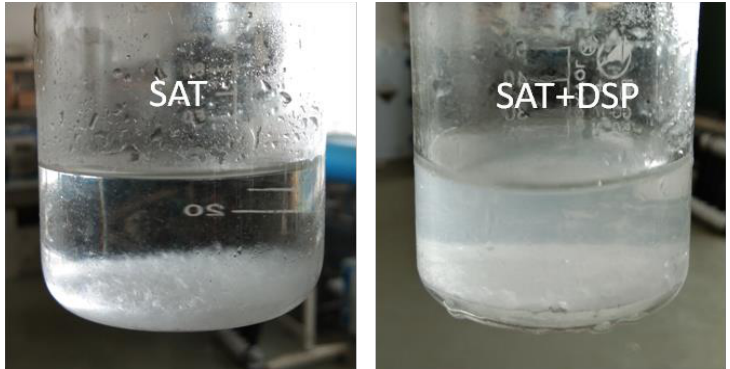
Figure 5. Phase separation and precipitation.